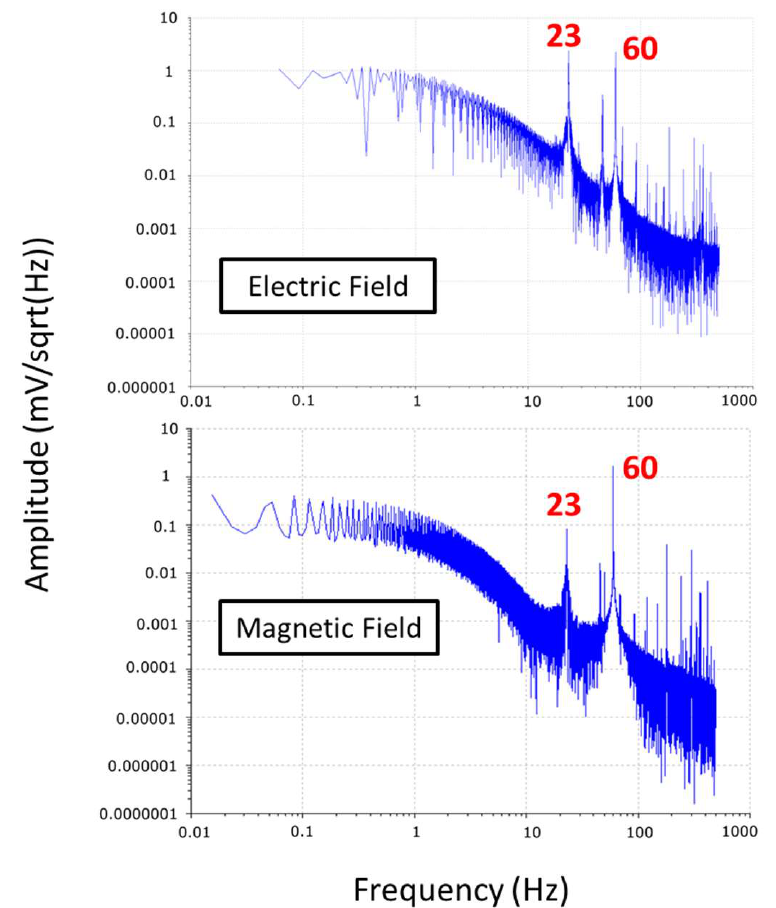
Figure 7. The spectrum of LOTEM data from receiver ST-01 ( top ), and ST-04 ( bottom ) are presented. We recognized periodic noise sources at 23 Hz and 60 Hz. Both noises likely come from the generator and the power lines.